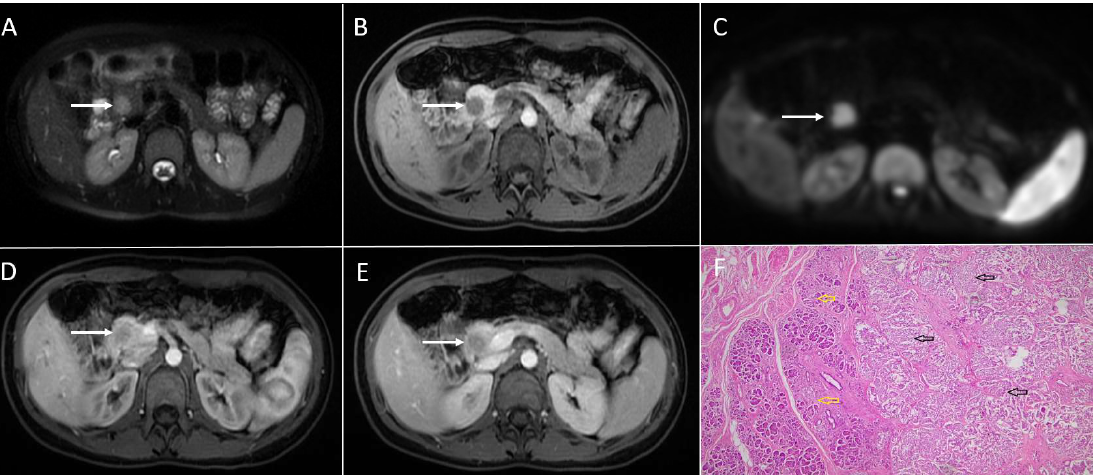
Figure 3. Solid pseudopapillary neoplasm of the pancreas in 18-year-old woman. Axial T2-weighted FS image ( A ) shows slightly round hyperintense lesion in the pancreatic head ( arrow ). The tumor is hypointense on T1-weighted image ( B ) with restricted diffusion on DWI (b = 800 s/mm 2 ) ( C ). In arterial phase, the tumor shows discrete enhancement ( D ) and remains hypointense in portal-venous phase ( E ). Hematoxylin and eosin (H&E) staining ( F ) showed solid pseudopapillary tumor ( black arrow ). Normal pancreatic parenchyma is also shown ( yellow arrow ); original magnification ×